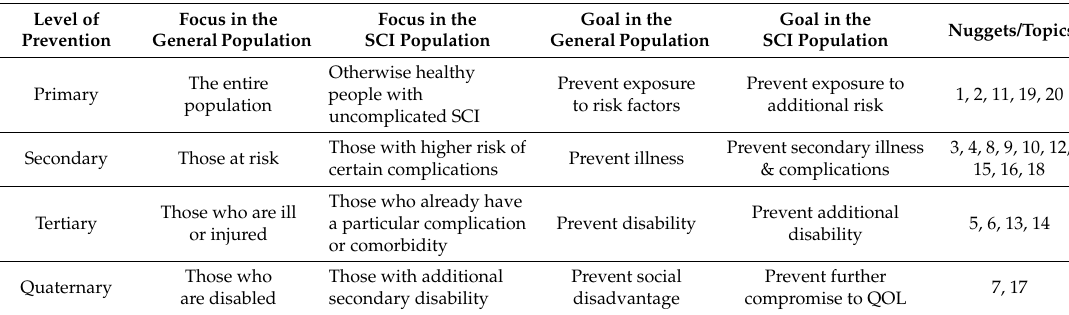
Table 4. Goals with respect to levels of prevention in SCI